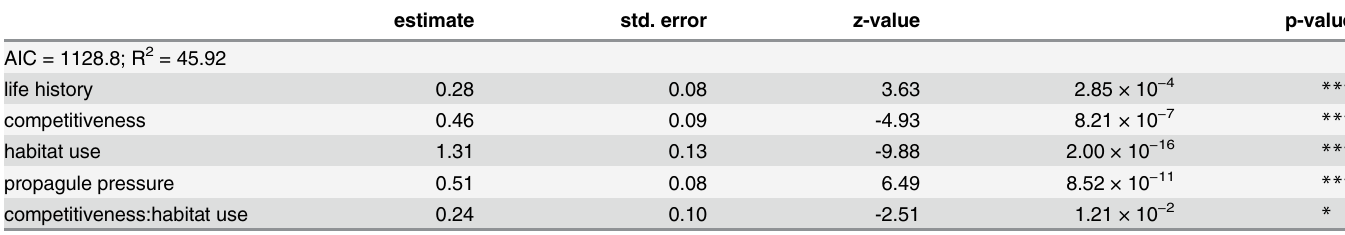
competitiveness:habitat use Traits represent fi rst axes of correspondence analyses of the respective trait groups (Table 1) which were standardized before running the GLMMs.